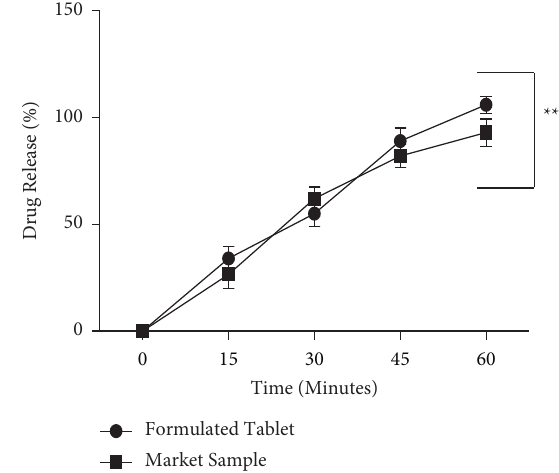
Figure 7: SRP release in buffer media (pH 6.8 phosphate buffer): ∗∗ P > 0 . 05 compared to market